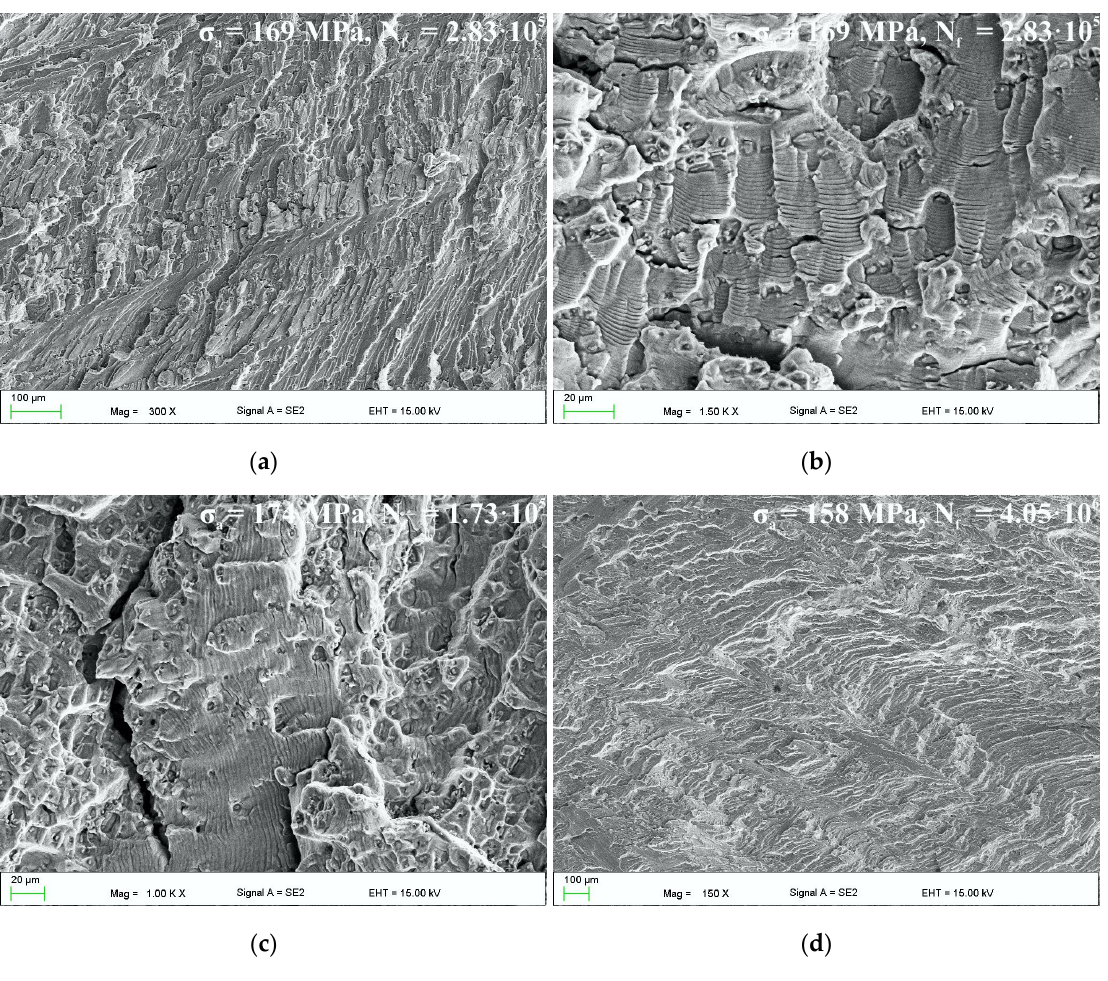
Figure 12. Fractures of fatigue test samples (oscillatory bending) of AlZn6Mg0.8Zr alloy, subjected to LTMP with 30% degree of deformation: ( a ) quasi-cleavage character of the investigated alloy fracture; ( b ) fatigue strip systems on the surface of cleavage planes; ( c ) secondary crack and adjacent fatigue strips ( d ) jogs systems on the fatigue fracture surface of investigated alloy forming rivers and river basins.